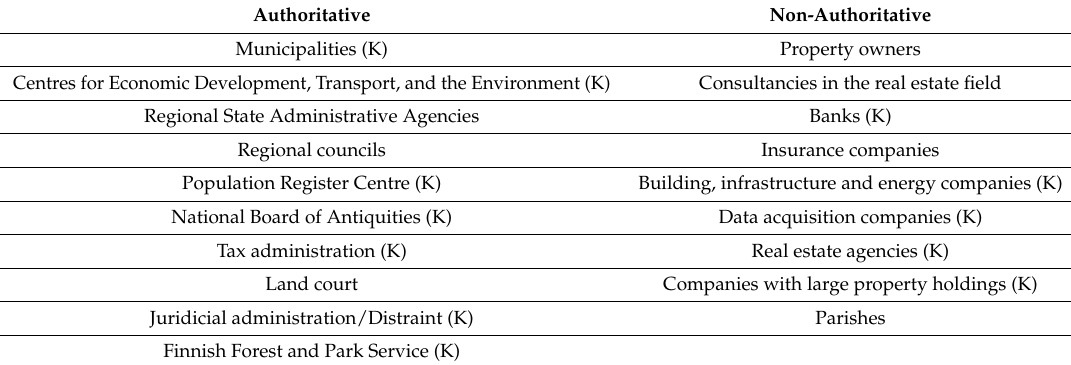
Table 1. Finnish land information service (FLIS) users and their key user status. The letter (K) denotes that the user group is considered a frequent and prominent user of